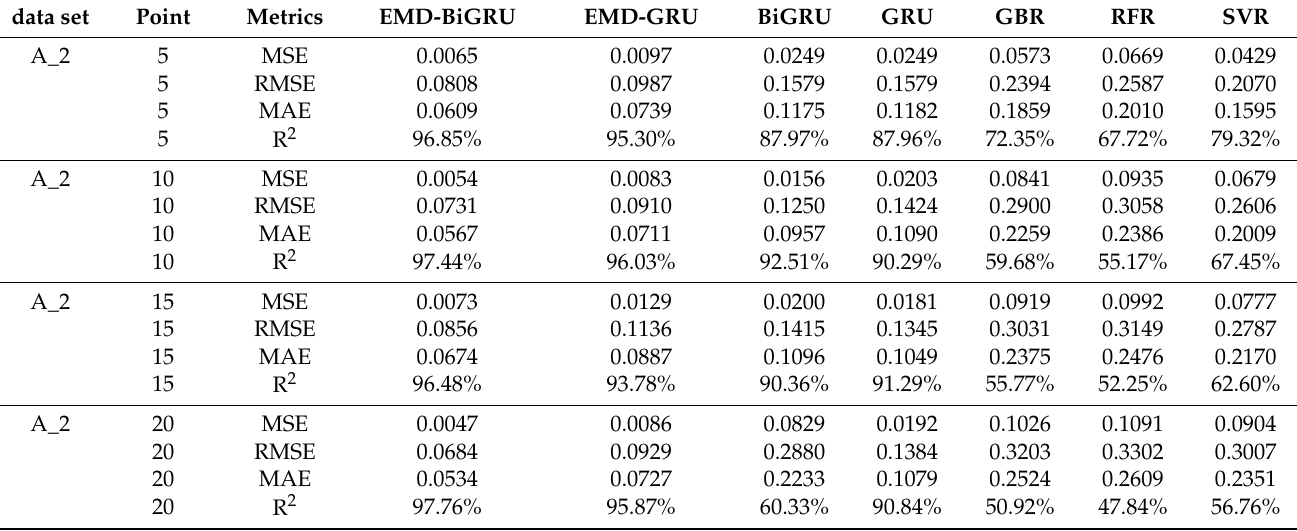
Table 1. Comparison results for data set A_2 using different